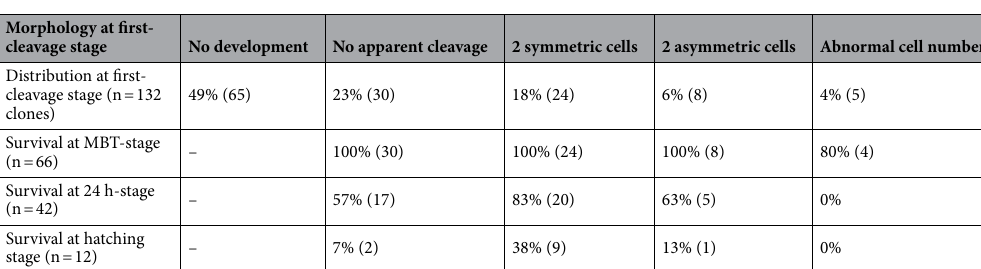
Table 1. Morphological distribution of the clones at the first-cleavage stage, and fate of the clones from each morphology up to hatching stage. A total of 132 clones were observed. Distribution at first cleavage stage was expressed as a percentage (%) of the 132 operated clones. Survival for each morphological type (columns) was expressed as % of the corresponding clone number at first-cleavage stage. Numbers between brackets: clone numbers. MBT mid blastula